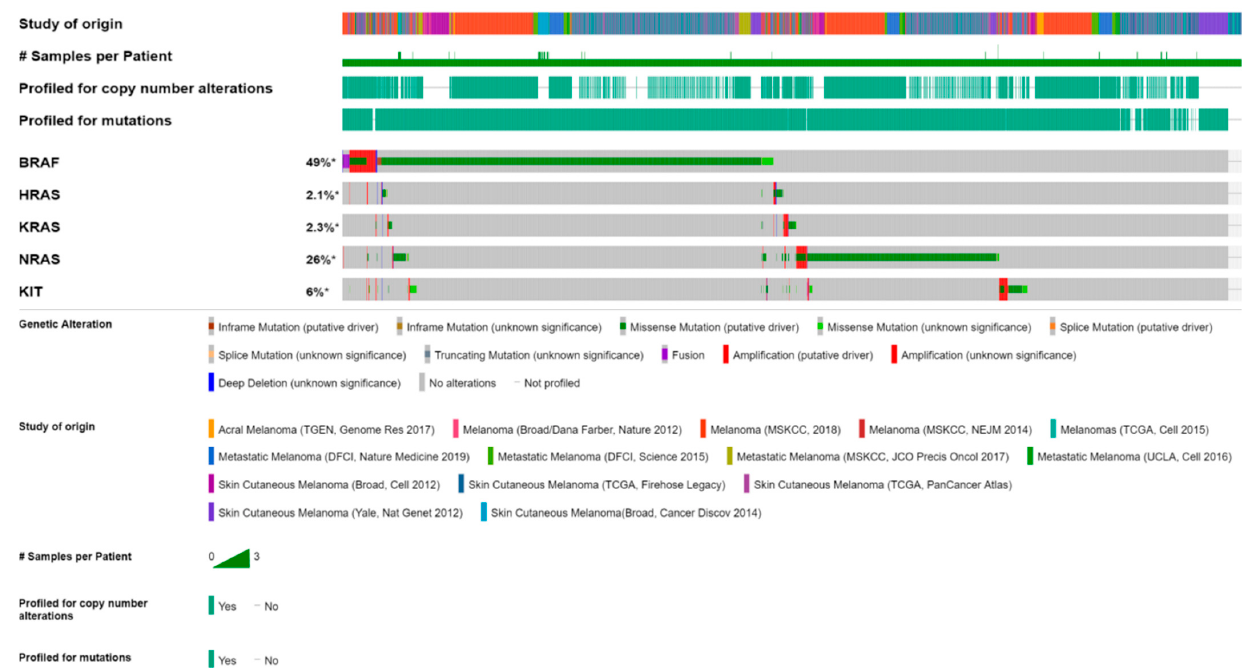
Figure 1. The heat map generated using cBioportal shows the mutation and copy number alteration of BRAF , HRAS , KRAS , NRAS , and KIT in melanoma multiple datasets. The type of the mutational status is presented in a color-coded fashion, with copy number aberration (amplification or deletion) and/or mutational state (truncating mutation, in frame mutation, missense mutation) across profiled oncogenes altered in SKMs.